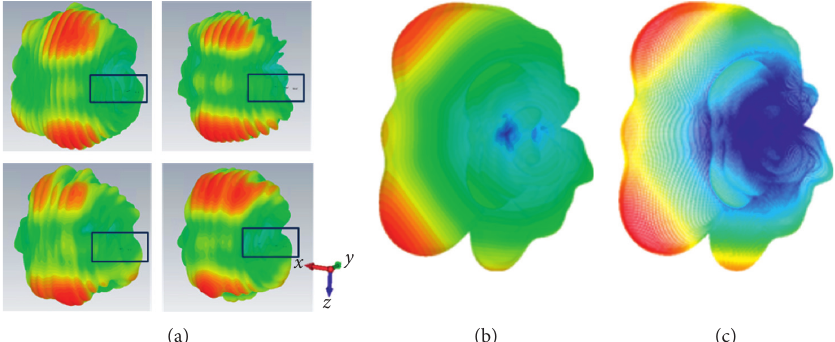
Figure 11: Codebook development process for ψ � 90 ° : (a) individual CST MBS radiation patterns; (b) CST; (c) APA TBX.